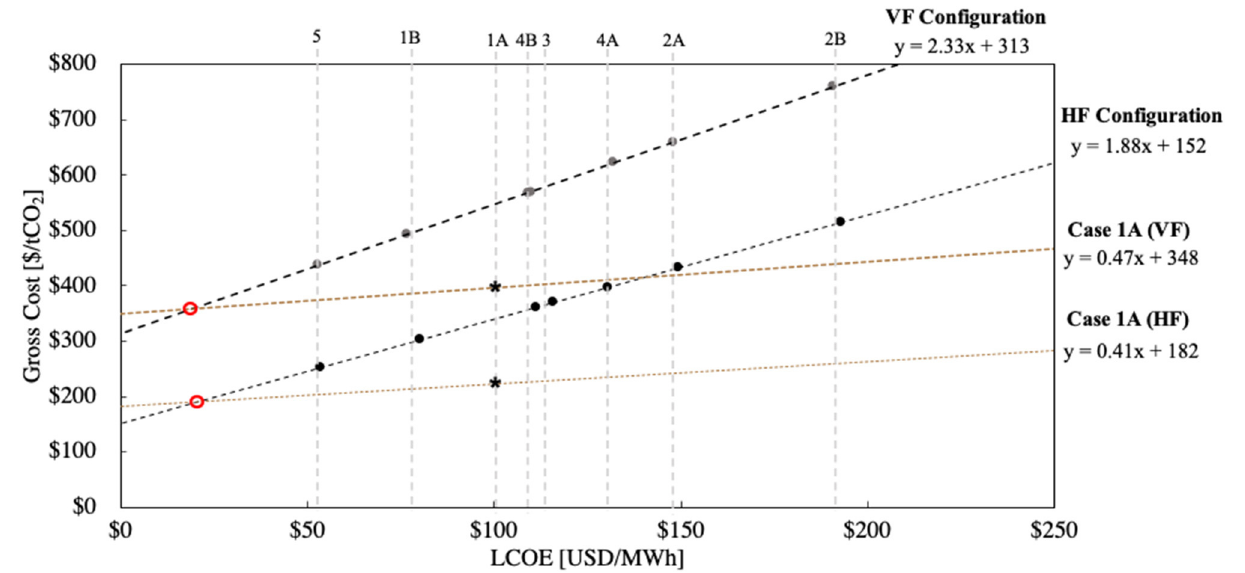
FIGURE 7 | Gross cost of CO 2 capture as a function of the levelized cost of electricity. The points for all cases other than Case 1A lie on a straight line, for the HF and VF variants separately. Case 1A is shown as a line, treating the cost of electricity produced at the small NGCC-CCS as a parameter. The points for Case 1A in this paper are shown as asterisks and the intersection of Case 1A and the all-electric alternatives as a red circle.